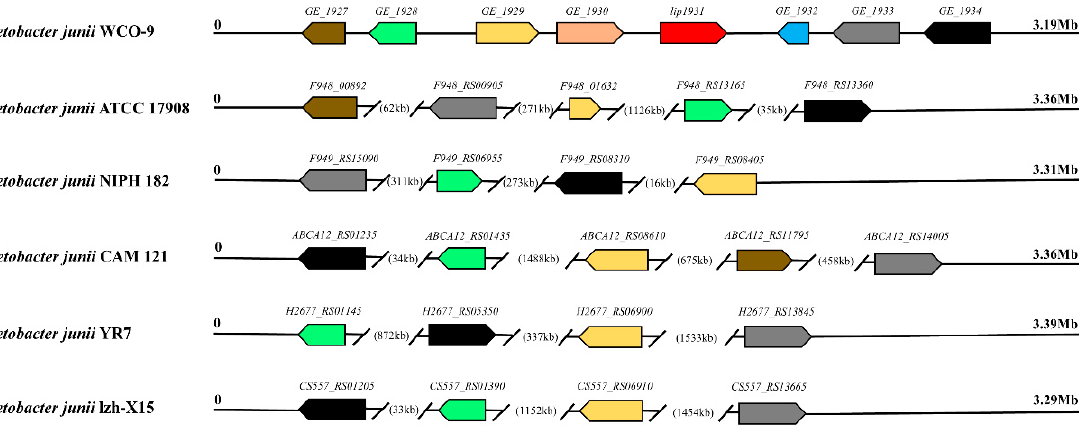
Figure 7. Comparison of the two flanking genes of the WCO-9 strain-specific lipase gene ( lip1931 ). The same color represents the same gene.